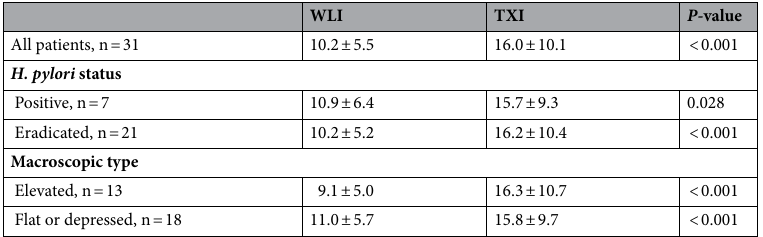
Table 2. Color differences between EGCs and the surrounding mucosa on WLI and TXI (objective appearance of EGCs). Data regarding color differences are presented as the mean and standard deviation. TXI Texture and color enhancement imaging, WLI white-light imaging. Three patients, including 2 H. pylori- negative and 1 undetermined patient, were excluded from the